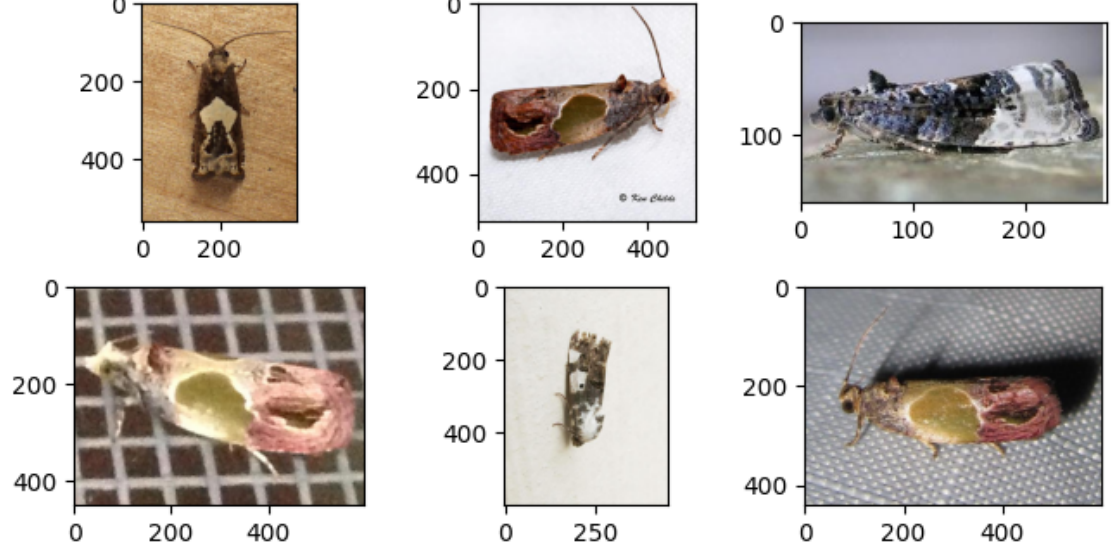
Figure 4. Six sample images of the Fieldguide Challenge dataset with dimensions.